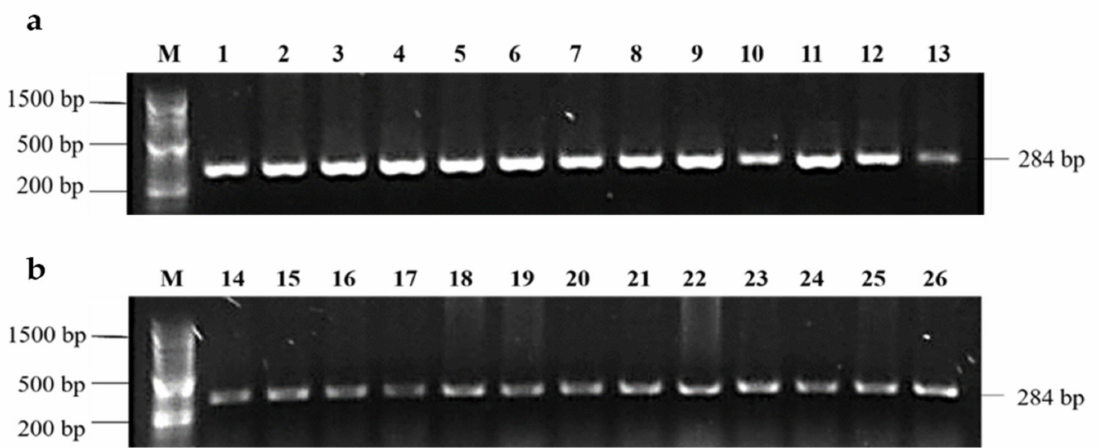
Figure 1. PCR amplification of 284 bp DNA fragment from the invasion gene invA of Salmonella isolated from broilers farms in Tolima, Colombia. M—100 bp marker; ( a ) lanes 1–12 and ( b ) lanes 14–25— Salmonella isolates from Tolima broiler farms; lane 13 and 26—positive control Salmonella Enteritidis ATCC